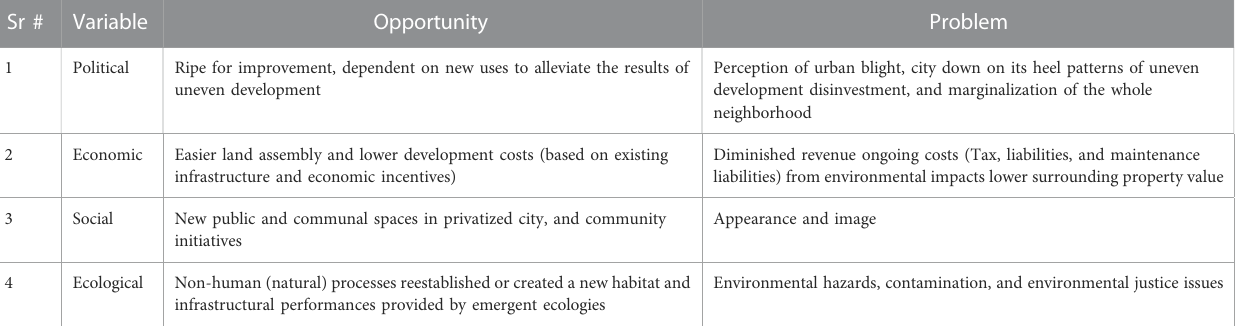
The Figure 9 selected under-utilized parcel or urban voids are adjacent to and divided by the railway line (existing as Pakistan ’ s commonly used communication mode). The identi fi ed areas were